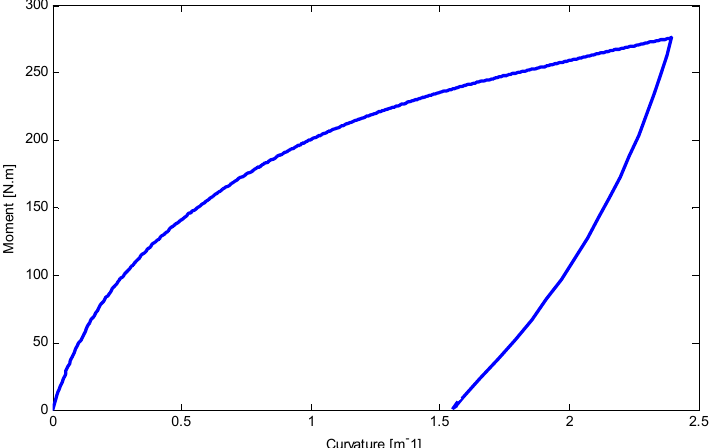
Figure 22. The relationship between curvature and moment for the circular SMA beam under four-